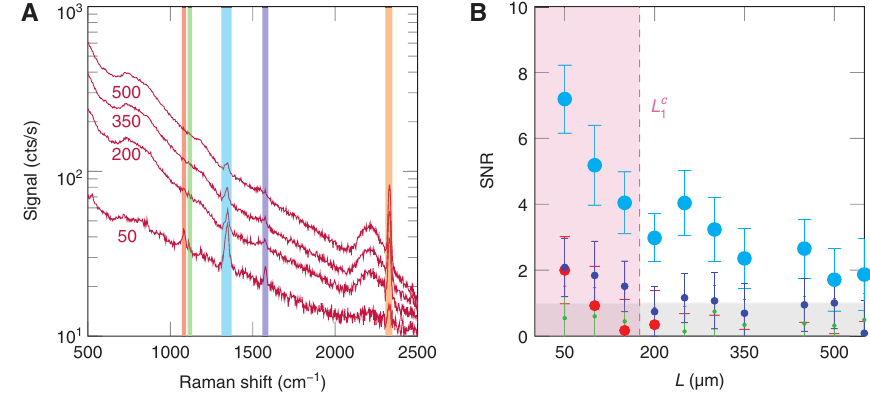
Figure 3: SiN Raman background with increasing length of the access waveguide. (A) Backscattered Raman spectra of a waveguide covered with N = 1 antenna and varying length L = 50 … 500 m. The lengths L are mentioned next to their corresponding Raman spectra, and the color codes for the lines are the same as in Figure 1. (B) SNR of all peaks for N = 1. Each color corresponds to the respective peak in the Raman spectrum. The grey shaded area represents SNR < 1 and hence marks a region where detection is impossible. The purple shaded area represents the region where all peaks have an SNR >